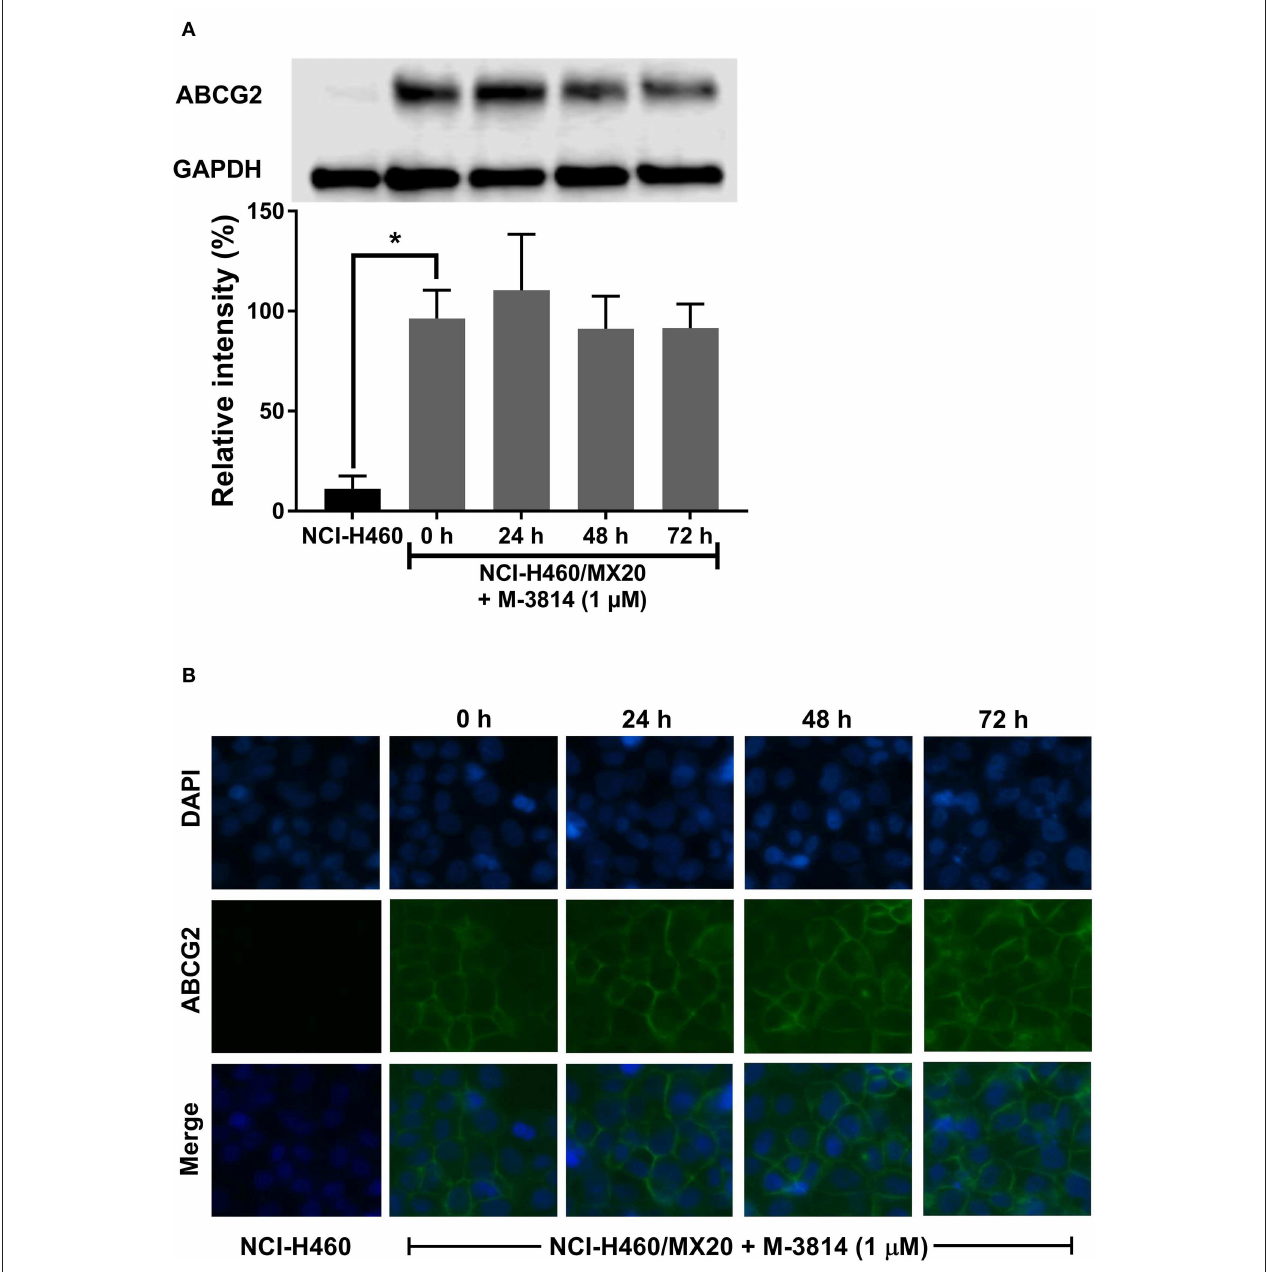
FIGURE 6 | M3814 did not affect the ABCG2 protein expression or cell surface localization. (A) The effect of M3814 on the expression level of ABCG2 in NCI-H460 and NCI-H460/MX20 cells. (B) Cell surface localization of ABCG2 expression in NCI-H460/MX20 cells incubated with 1 µ M of M3814 for up to 72h. Data are expressed as mean ± SD from three independent experiments. * p < 0.05 vs. the control